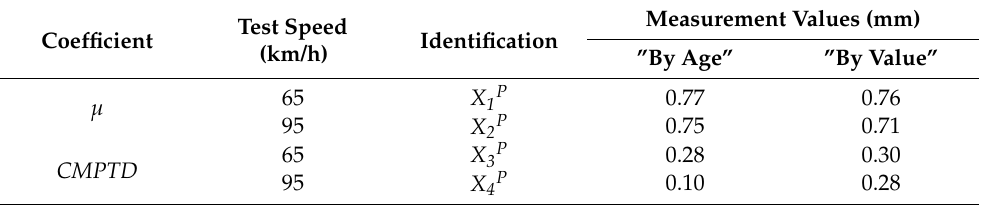
Table 8. Field tests results for cement concrete—model I (two speeds separately).